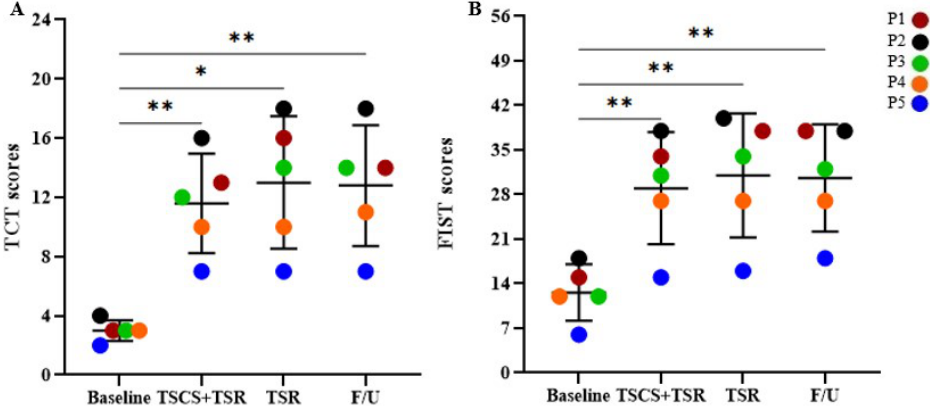
Figure 5. The increased functional scores of ( A ) TCT (0–24 points) and ( B ) FIST (0–56 points) measured from the baseline for each participant during the study. Statistical analysis was conducted between the baseline with TSCS+TSR, TSR, and follow-up. TCT, Trunk Control Test; FIST, Function in Sitting Test; TSCS, transcutaneous electrical spinal cord stimulation; TSR, task-specific rehabilitation; F/U, follow-up; ⁎ p < 0.05, ** p < 0.01, all in comparison to the baseline value.